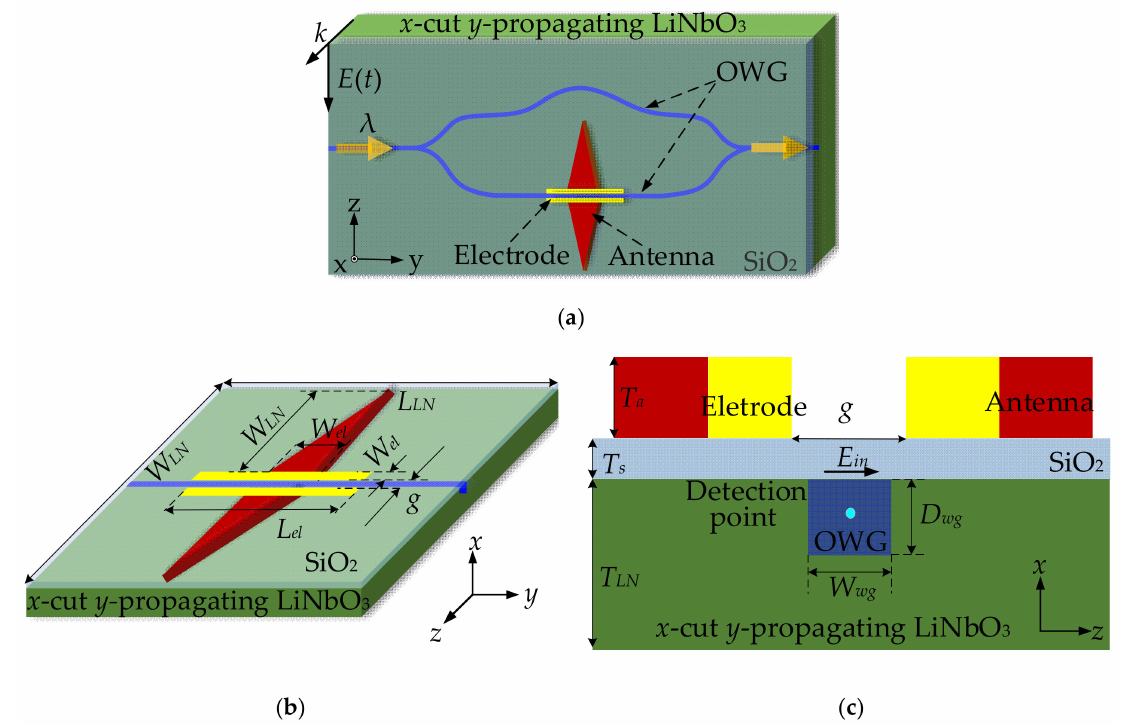
Figure 1. Schematic of the integrated optical electric field sensor: ( a ) sensor structure; ( b ) antenna and electrode; ( c ) x-z plane cross